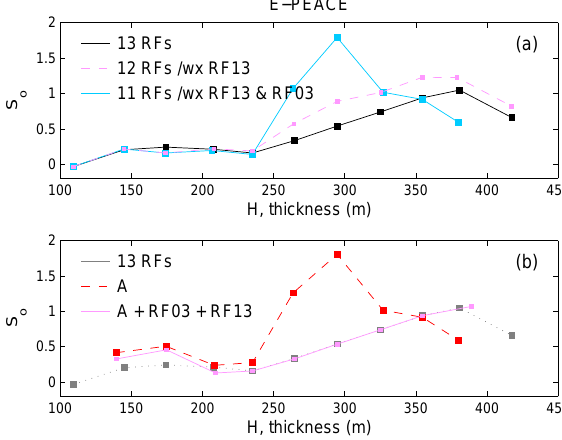
Figure 9. The effects of high precipitation (RF03 and RF13) on S o estimates. (a) S o calculated for 13 flights during E-PEACE in ad- dition to when either, or both, RF03 and RF13 are excluded. RF03 and RF13 are the flights of high precipitation rates. (b) S o is cal- culated from group A with and without RF03 and RF13. R and N d information for each flight is shown in Fig.